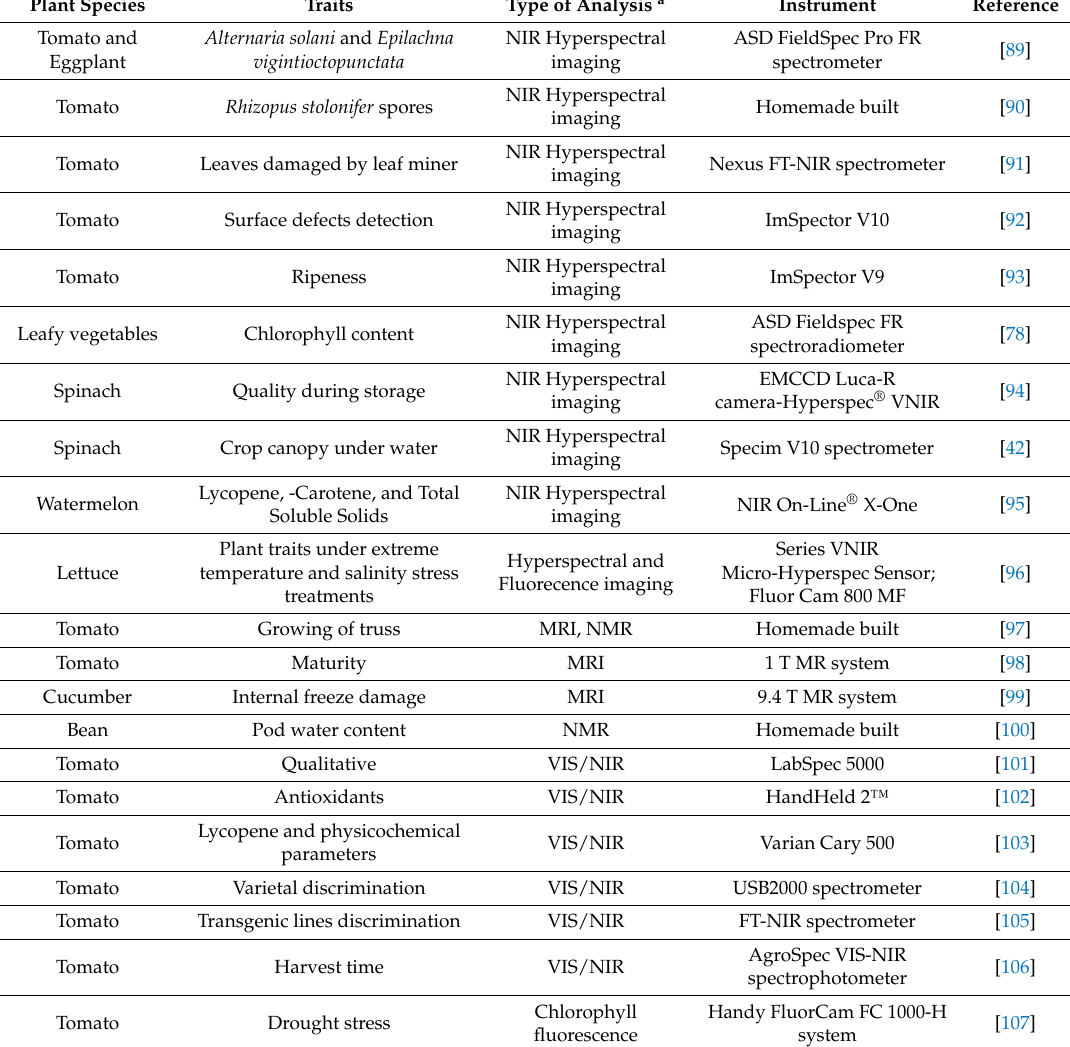
Table 2. List of studies performed in vegetables by means of nondestructive sensors for small-scale phenotyping and by means of portable